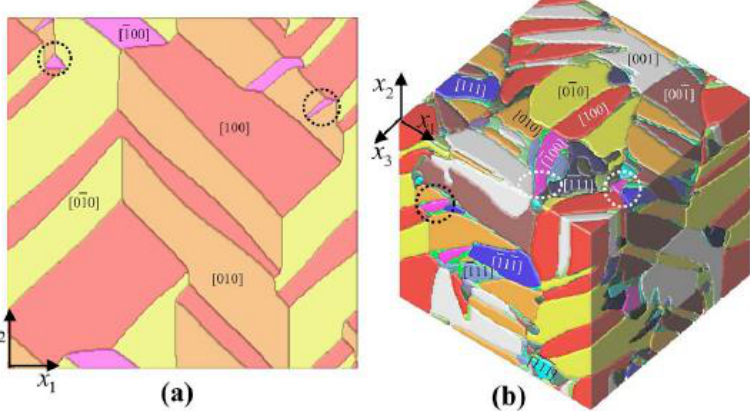
Figure 4. Domain structures of a PZT single crystal obtained from the phase field model by Choudhury et al. [48]. The polarization directions of the distinct phases and domain types are shown in different colours. (a) Domain structure from the 2D